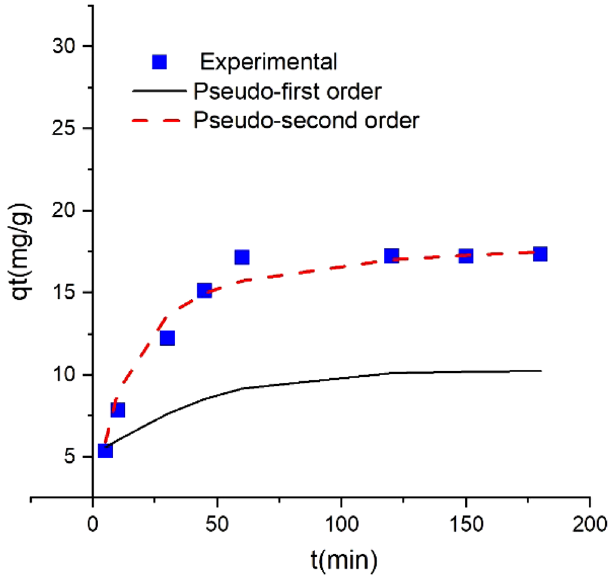
Figure 12. Comparing the theoretical kinetic values with the experimental